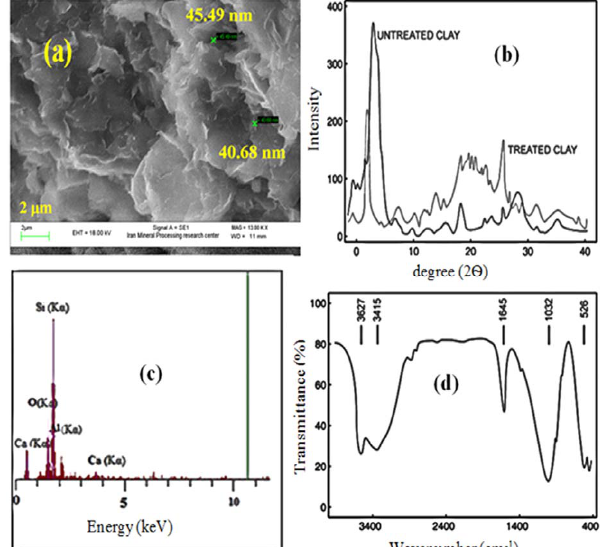
Fig. 1. (a) SEM images, (b) The XRD patterns of the Ghezeljeh nanoclay are treated with ethylene glycol, (c) EDX spectrum, (d) FT-IR spectrum of untreated Ghezeljeh nanoclay.